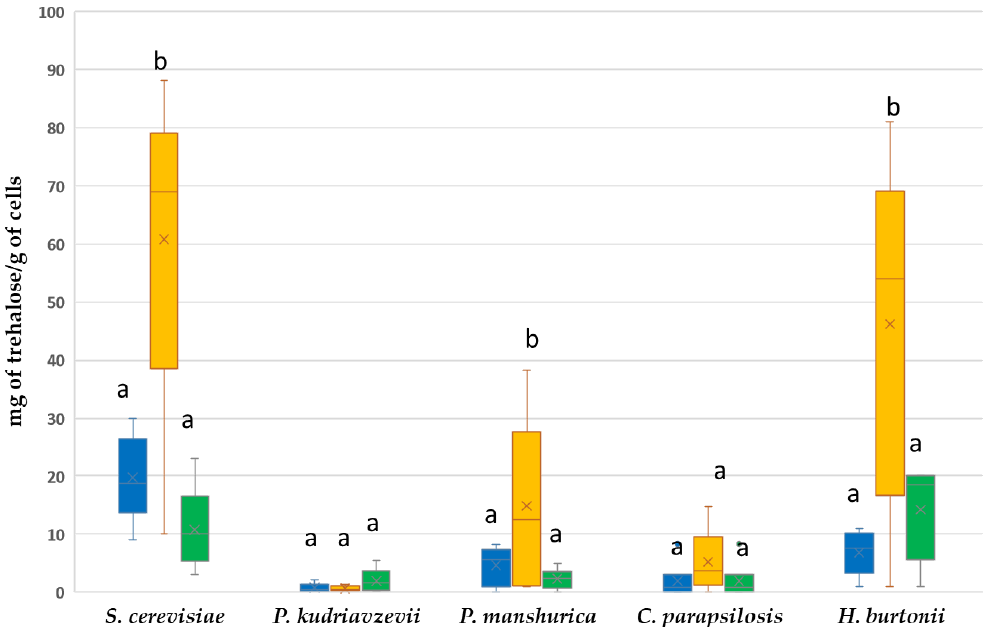
Figure 4. Trehalose content in yeasts isolated from Colombian fermented and dry cocoa beans exposed to heat shock treatment at 46 °C in CPSM liquid medium for 2 h. Blue: untreated control, Yellow: yeasts treated in CPSM; Green: yeasts treated in YPD. Values not sharing a letter in common differ significantly ( p < 0.05 from each other) as determined by Duncan’s multiple range test.